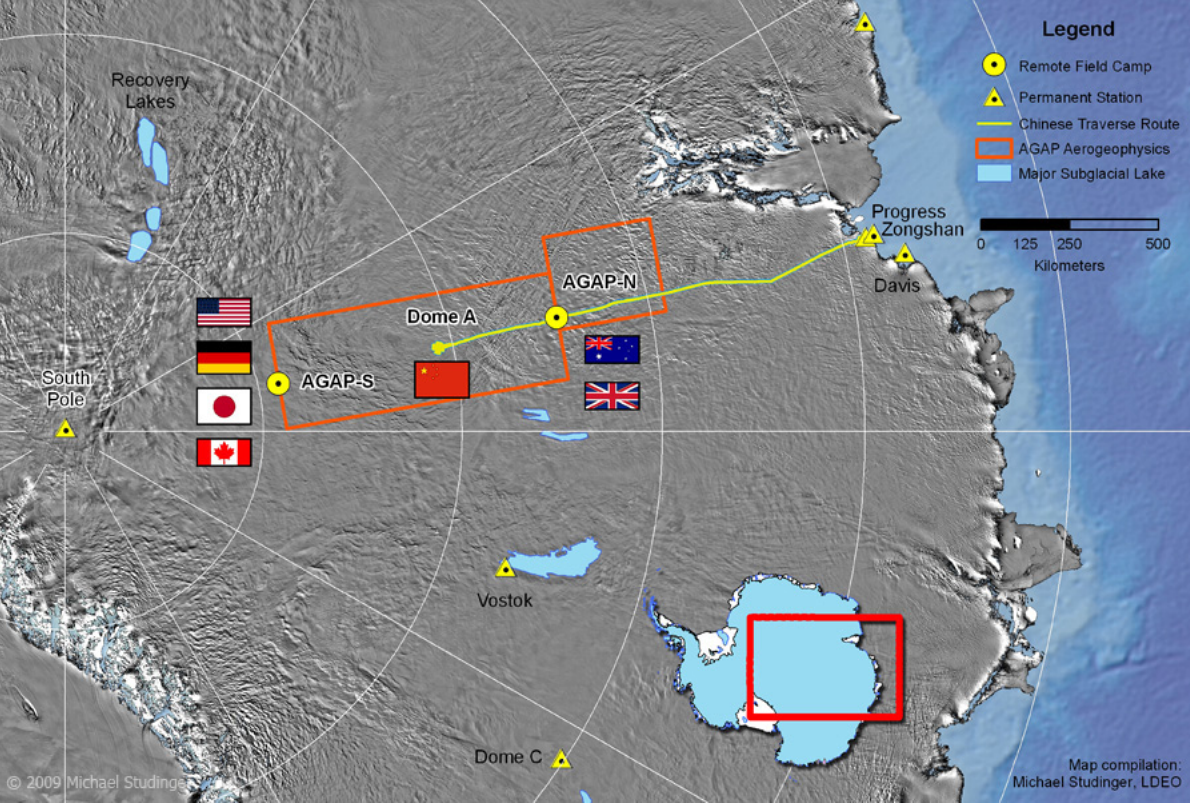
Figure 1. Location map of the field camps utilized during the AGAP which occurred during the IPY. The two camps for AGAP-N and -S had been operated for supporting flight operations of the air-bone geophysics and seismic deployments in wide area of the East Antarctic ice sheet. The Chinese ground traverse route from Zhong Shan Station to Dome-A is illustrated by the solid yellow